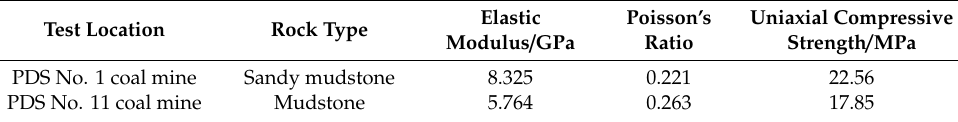
Figure 8. Roadways distribution of test location in PDS No. 11 coal mine. Table 1. Average value of rock parameters obtained from uniaxial compression